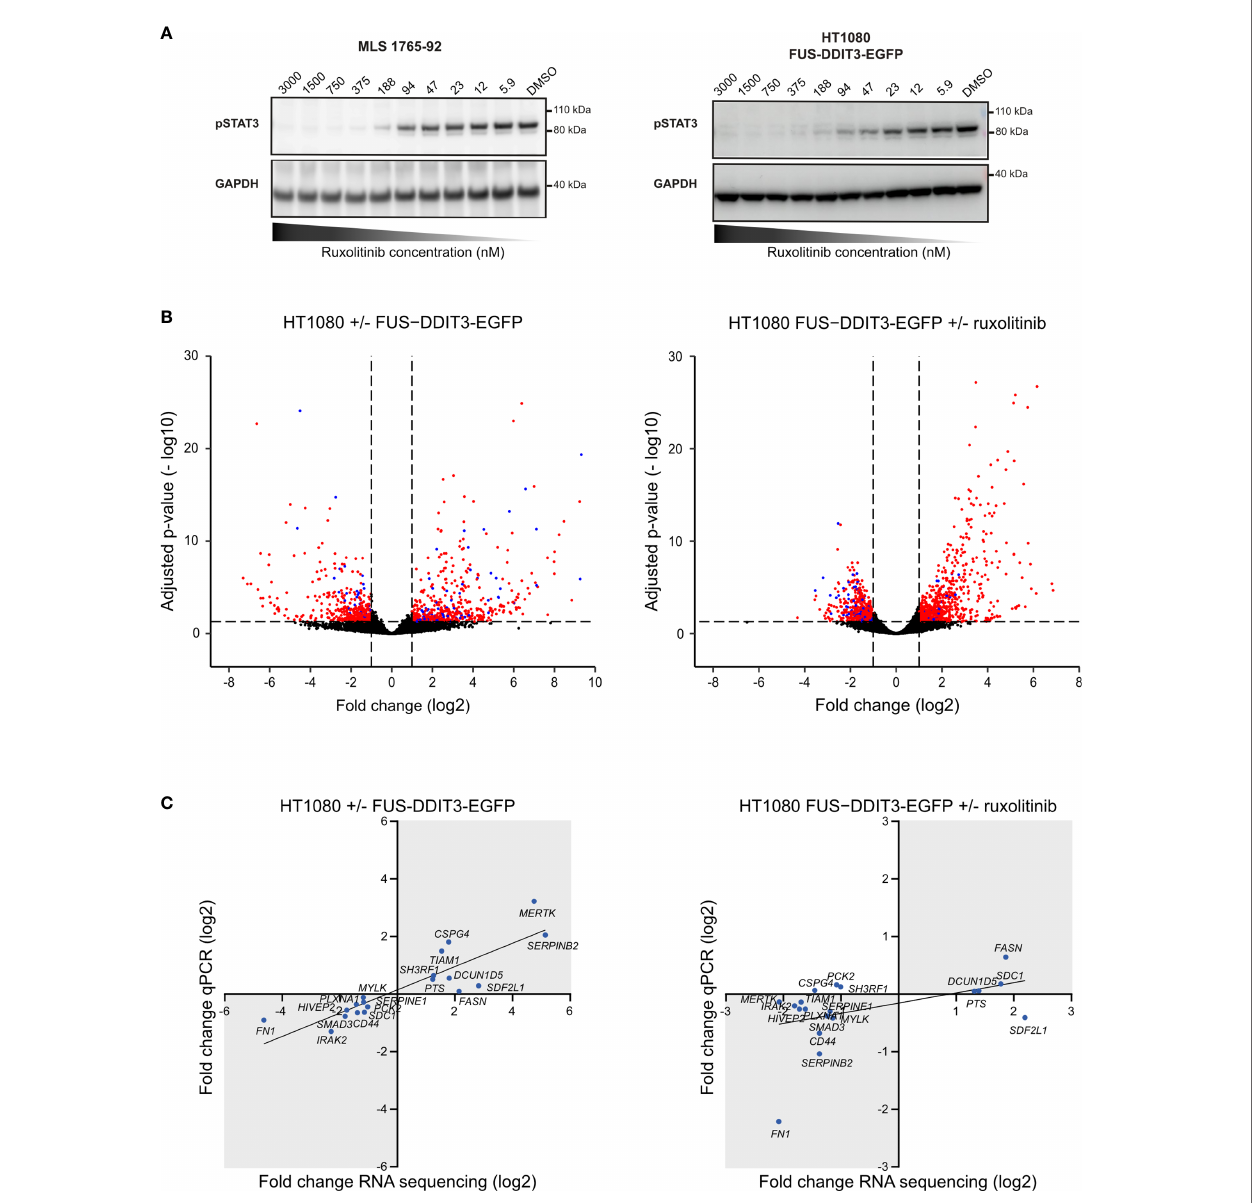
FIGURE 2 | Genes regulated by FUS-DDIT3 expression and ruxolitinib treatment. (A) Ruxolitinib dose-dependent phosphorylated STAT3 expression. Western blot analysis of pSTAT3 using GAPDH as loading control in myxoid liposarcoma (MLS) 1765-92 cells and HT1080 FUS-DDIT3-EGFP cells treated for 24 h with 5.9 – 3,000 nM ruxolitinib. DMSO was used as control, i.e., 0 nM ruxolitinib. Complete Western blot membranes are shown in Supplementary Figure 2 . (B) Differential gene expression analysis. Volcano plots showing signi fi cantly regulated genes comparing cells with and without FUS-DDIT3 expression (HT1080-FUS-DDIT3-EGFP vs. HT1080 wild-type) and FUS-DDIT3-expressing HT1080 cells with and without ruxolitinib treatment, respectively. Signi fi cantly regulated genes, with fold change ≥ 2 and adjusted p -value ≤ 0.05, are shown in either red or blue. Blue dots represent genes that are commonly regulated by both FUS-DDIT3 expression and ruxolitinib treatment. n = 3 – 4 per condition. (C) Quantitative PCR validation of RNA sequencing data. The linear fi ts are shown to guide the eye. Genes in gray areas are considered to be validated. n = 4 per